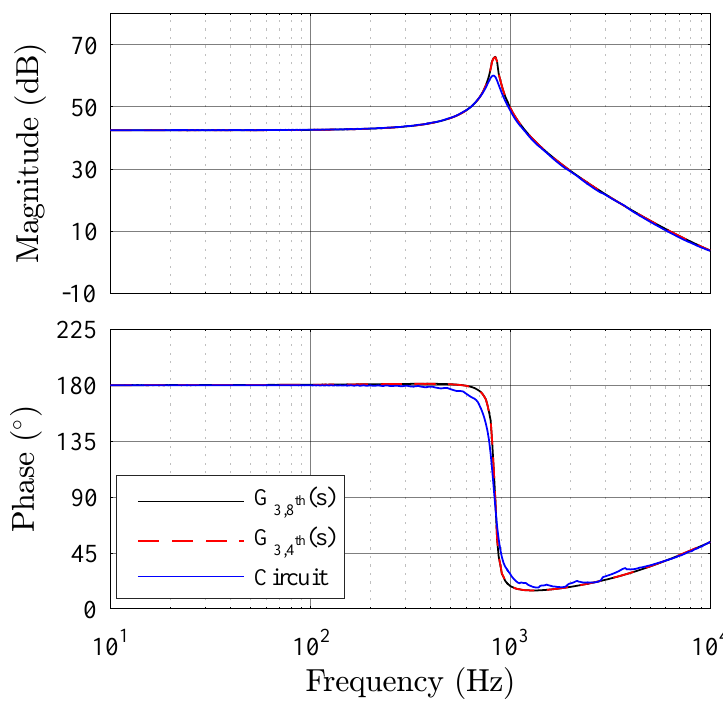
Figure 4. Bode diagram of the duty cycle to input voltage transfer function for the SICIBB converter.